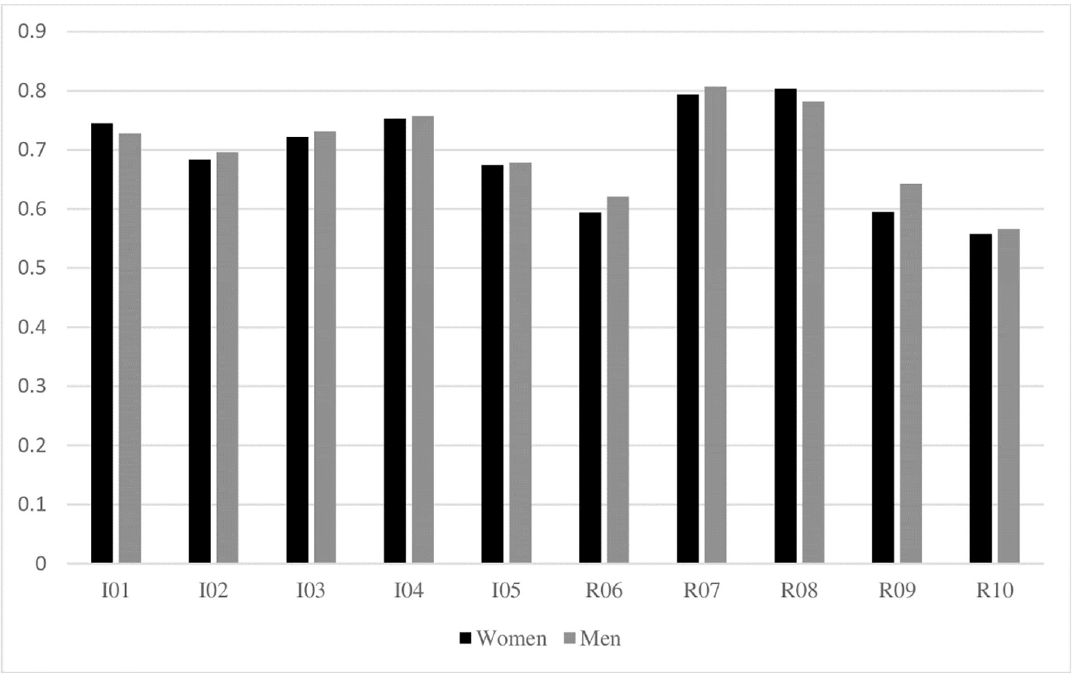
Fig 1. Standardized factor loadings across sexes. Note: I = Idealism, R = Relativism. Item numbers correspond to the ten items of the EPQ-5 supplied in the